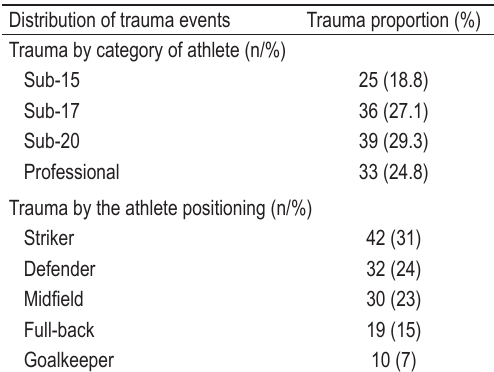
TABLE 3. Distribution of orofacial injuries by category